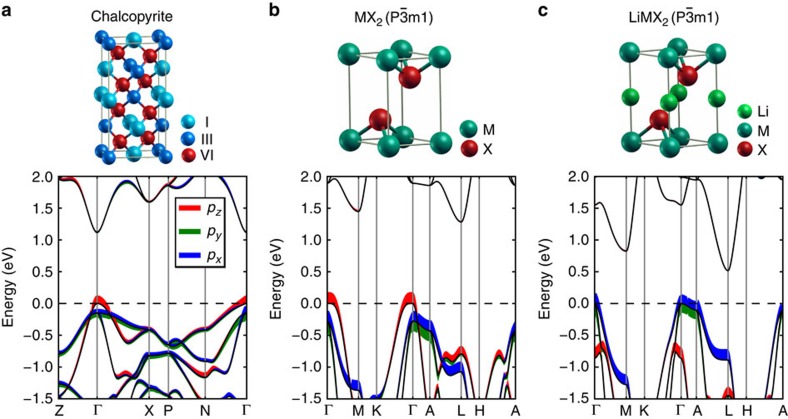
Extension of orbital engineering to several other non-cubic compounds.(a–c) Orbital-projected band structures and crystal structures of representative chalcopyrite compound AgGaTe2 (a), metal dichalcogenide ZrS2 (b) and lithium intercalated metal dichalcogenide LiZrSe2 (c). px, py and pz orbitals of anions are projected on the band structures. Curve width indicates the relative weight of the component.